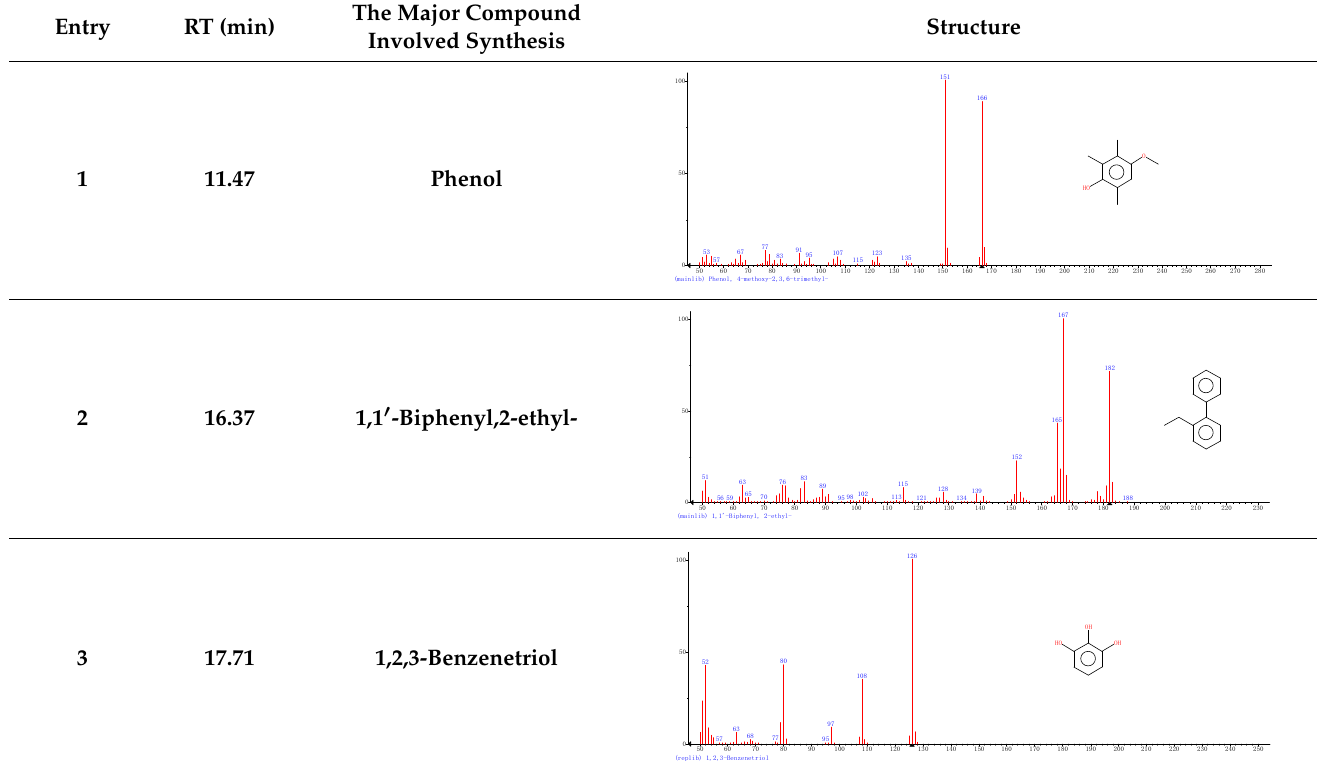
Figure 7. GC-MS chromatograms of GT (upper line) and n Fe (lower line). Table 1. Mass spectrometry classification of the main biomolecules in GT.